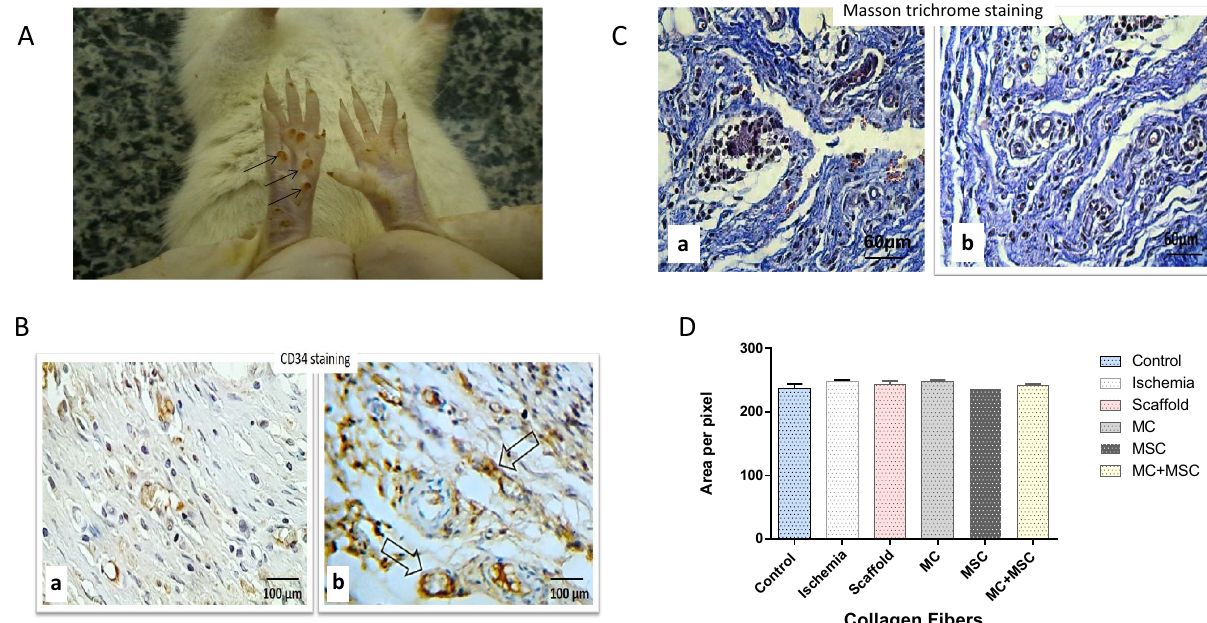
Figure 3. Illustration showing the necrosis in the ischemic left foot pad and histomorphometric analysis of collagen fibers in the femoral artery resected area. ( A ) Representative visual picture of ischemia-induced necrosis (arrowed) of the foot pad. ( B ) Representative immunohistochemical staining for CD34. Endothelial cells appeared brownish-yellow to dark brown with the chromogen. The CD34 endothelial marker demonstrates the intensity of blood vessels in a control animal (a) in comparision to an animal with ischemic tissues where cells were implanted (b). Images are representative of at least n = 5 independent experiment. ( C ) A representative micrograph showing individual morphometric analysis of Masson’s trichrome stained large blood vessels in a control animal (a) compared with an animal with ischemic tissues where cells were implanted. Collagen deposition is detected by a blue color. Images are representative of at least n = 5 independent experiment. ( D ) Histogram showing the mean pixel-based intensities of the blue-staining representing collagen fibers at 2530 µm × 2530 µm a reads of tissue in the different groups. All data are presented in mean ± SEM from 5 animals per group with the left hind limbs acting as a